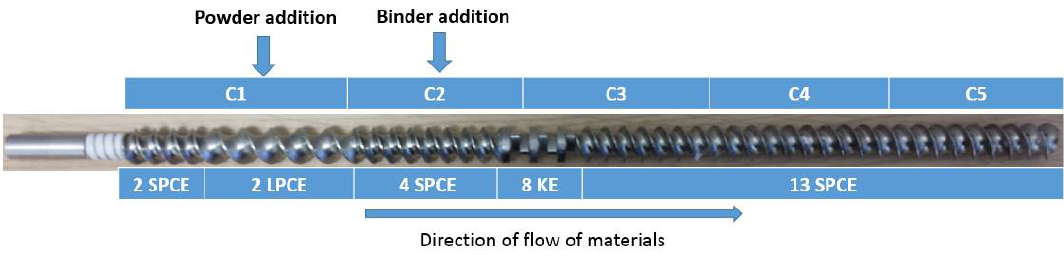
Figure 1. Screw configuration with various compartments. C1-C5: TSG Compartments 1-5; SPCE: